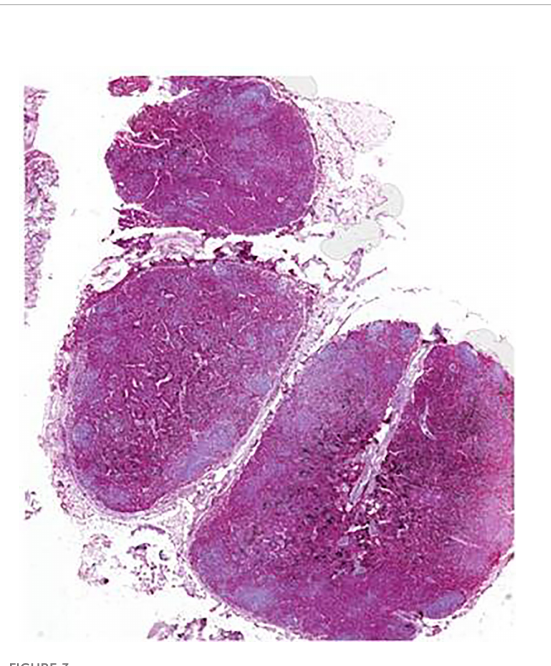
FIGURE 3 Lymph node biopsy from case 2 with myeloperoxidase staining showing in fi ltration of myeloid precursors; scale bar, 1,000 µm.